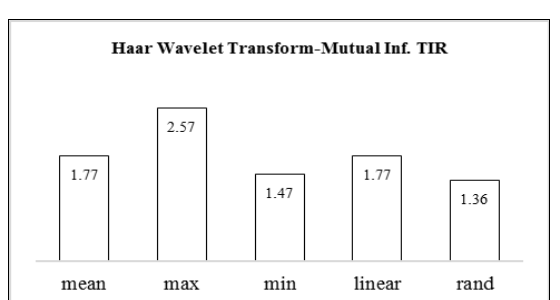
Figure 7. Mutual Information with respect to TIR for different filters